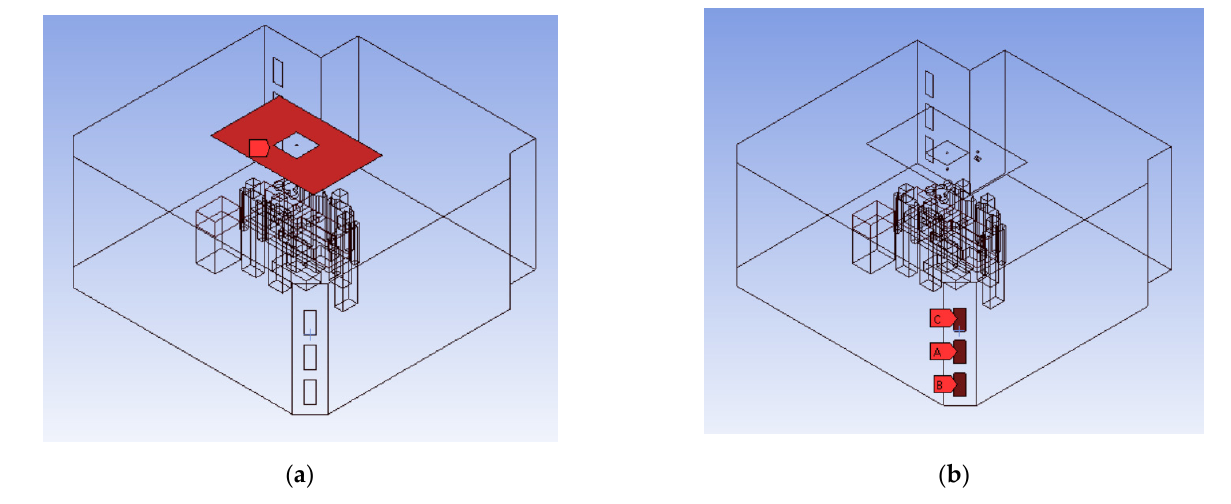
Figure 4. Distribution elements ( a ) LAFC and ( b ) exhaust diffusers.